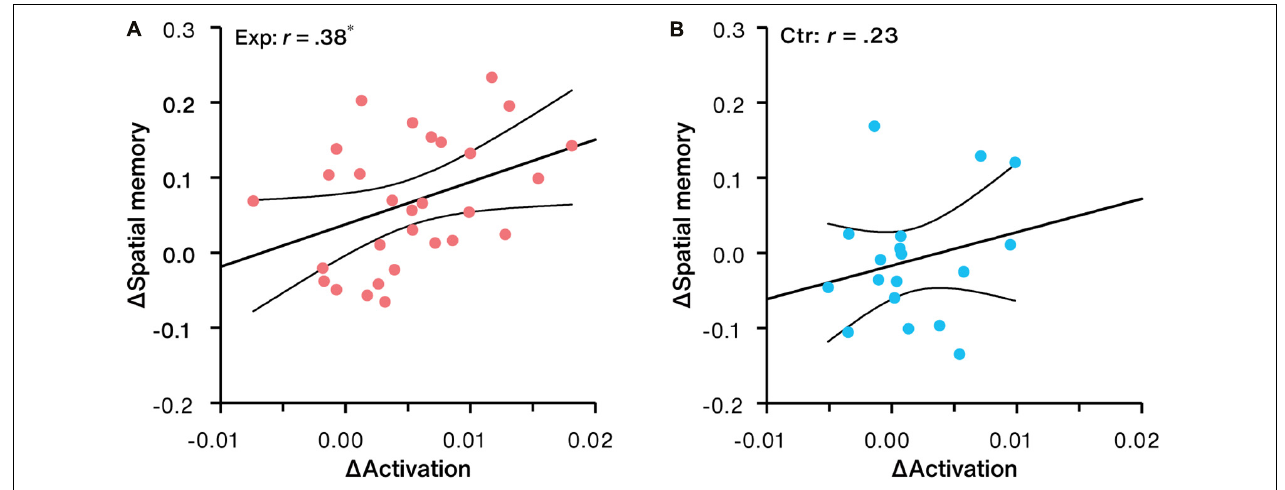
FIGURE 7 | Correlation between NFB-induced activation change in LPC and spatial memory change for the (A) experimental group (Exp) and (B) control group (Ctr). ∗ p <